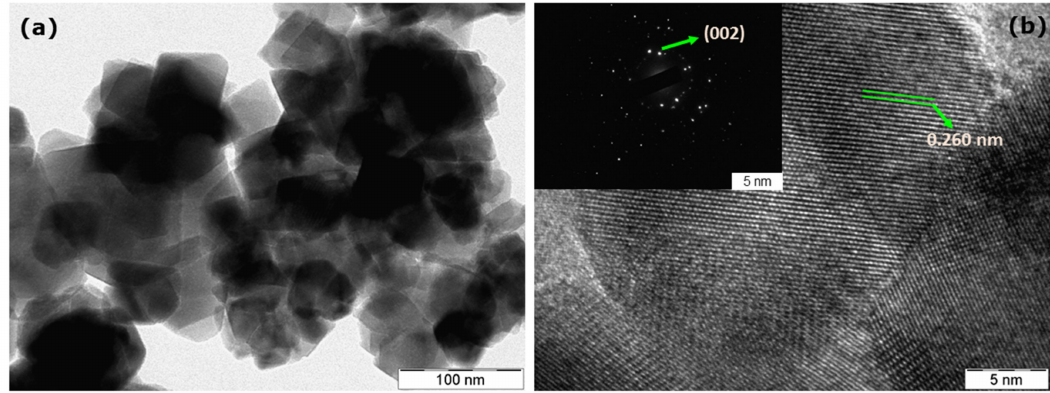
Figure 7. ( a ) TEM and ( b ) HR-TEM images with SAED (inset) of as-obtained ZnONPs.